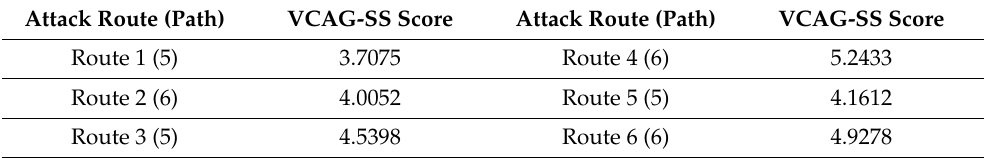
Table 9. VCAG-SS risk assessment results according to attack vectors.